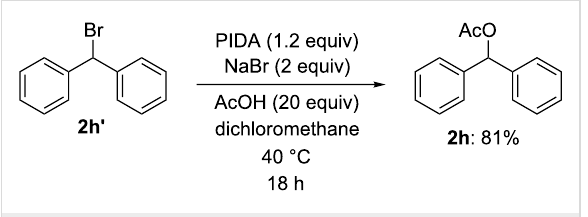
Scheme 5: Reaction of benzyl bromide 2h’ under radical C–H acetoxylation